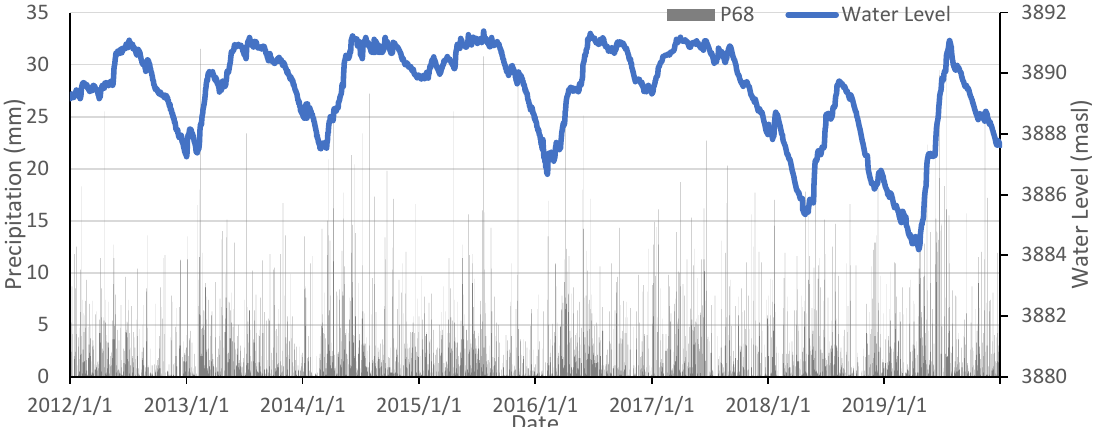
Figure 2. Time series of rainfall at the P68 station and reservoir’s water levels in meters above sea level